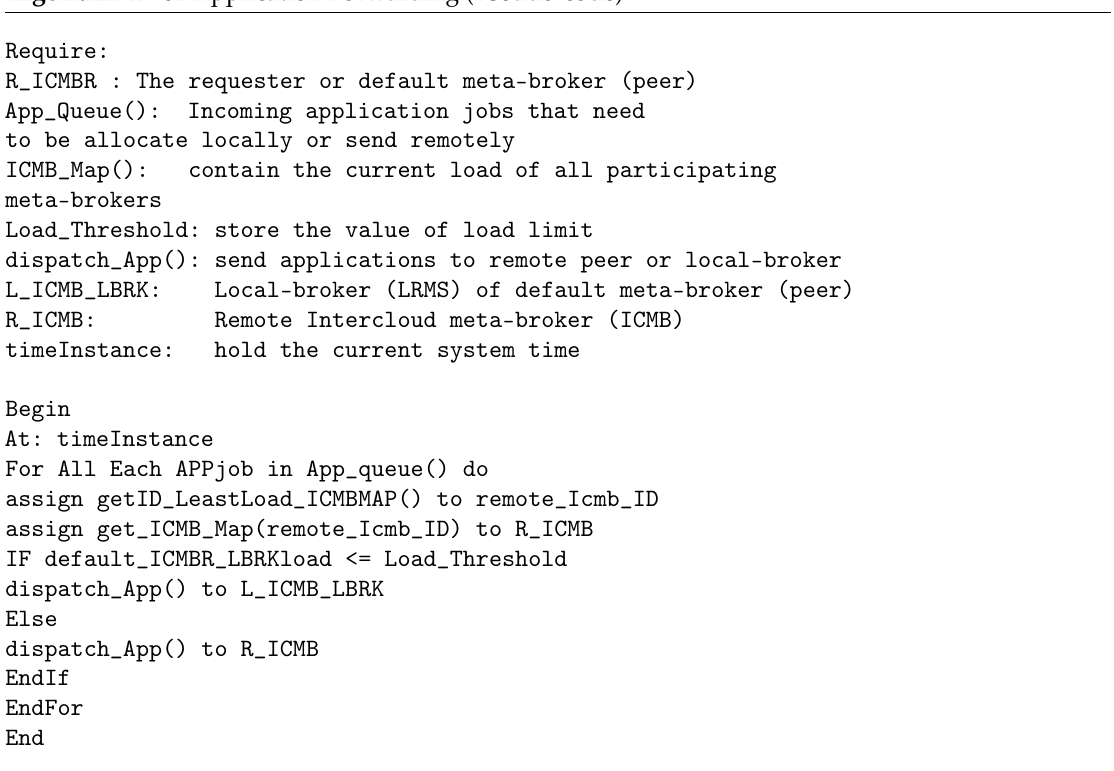
Algorithm 1 For Application Forwarding